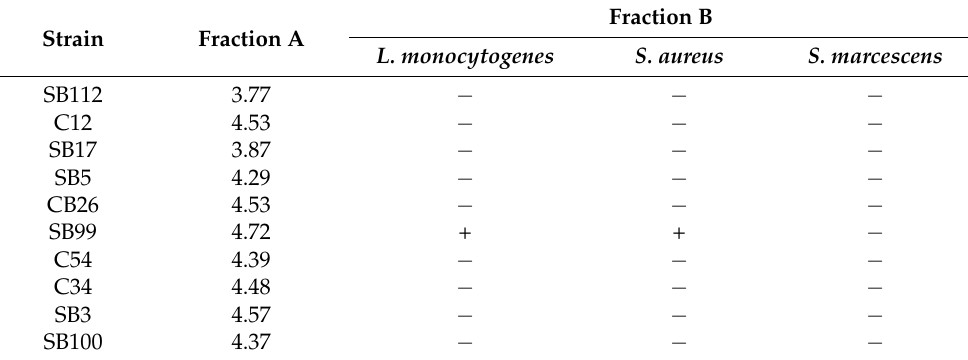
Table 5. Quantification of organic acids produced by LAB isolated from meat products.